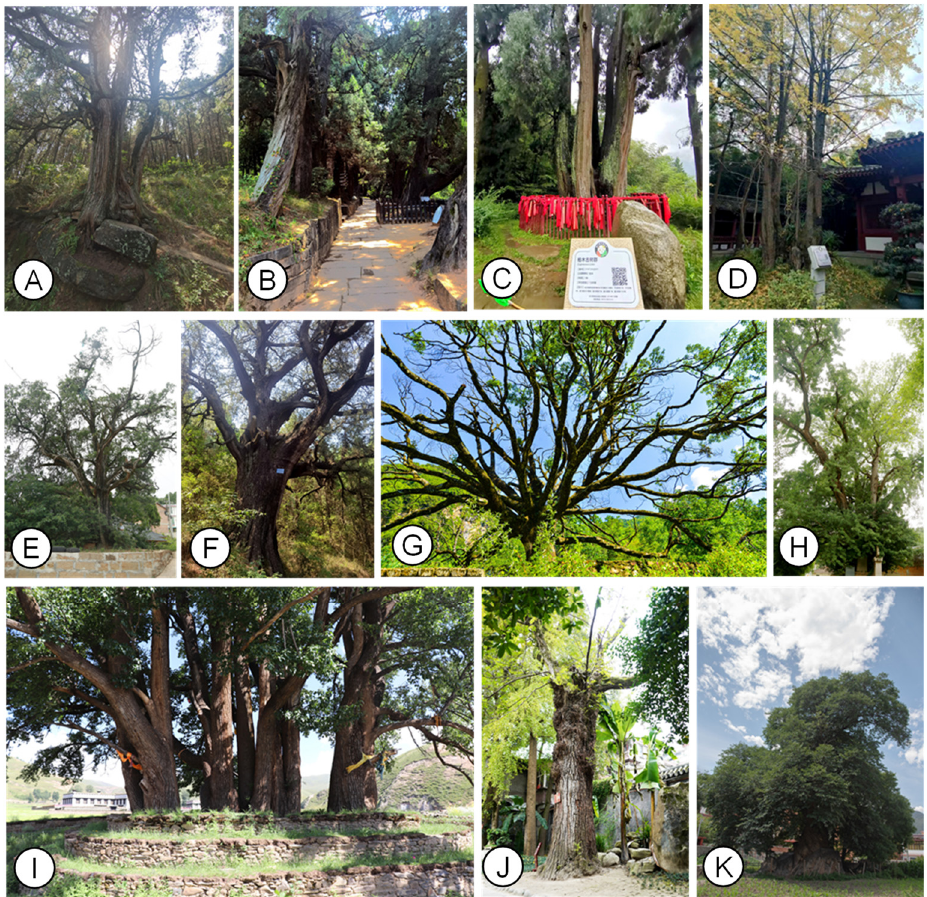
Figure 5. Photographs of main venerable trees and their habitats in Sichuan Province. Photo ( A – C ) and ( E , F ) denote Cupressus funebris (Cupressaceae); ( D ) and ( H ) Ginkgo biloba (Ginkgoaceae); ( G ) Machilus nanmu (Lauraceae); ( I ) Cinnamomum camphora (Lauraceae); ( J ) Pterocarya stenoptera (Juglandaceae); and ( K ) Morus australis